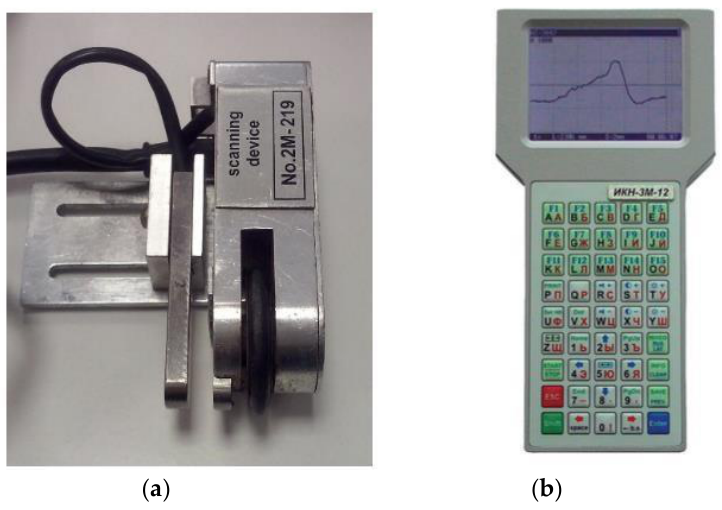
Figure 10. Instrumentation of the MMM inspection. ( a ) Scanning roller device with a fluxgate magnetometer type 2M. ( b ) Measurement equipment type TSC-3M-12.